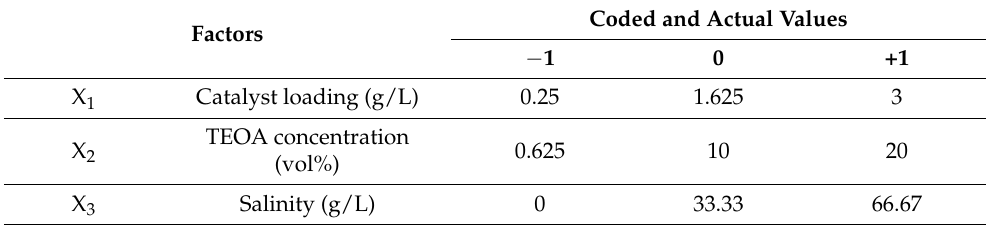
Table 1. The actual and coded values of the factors selected in Box–Behnken design.